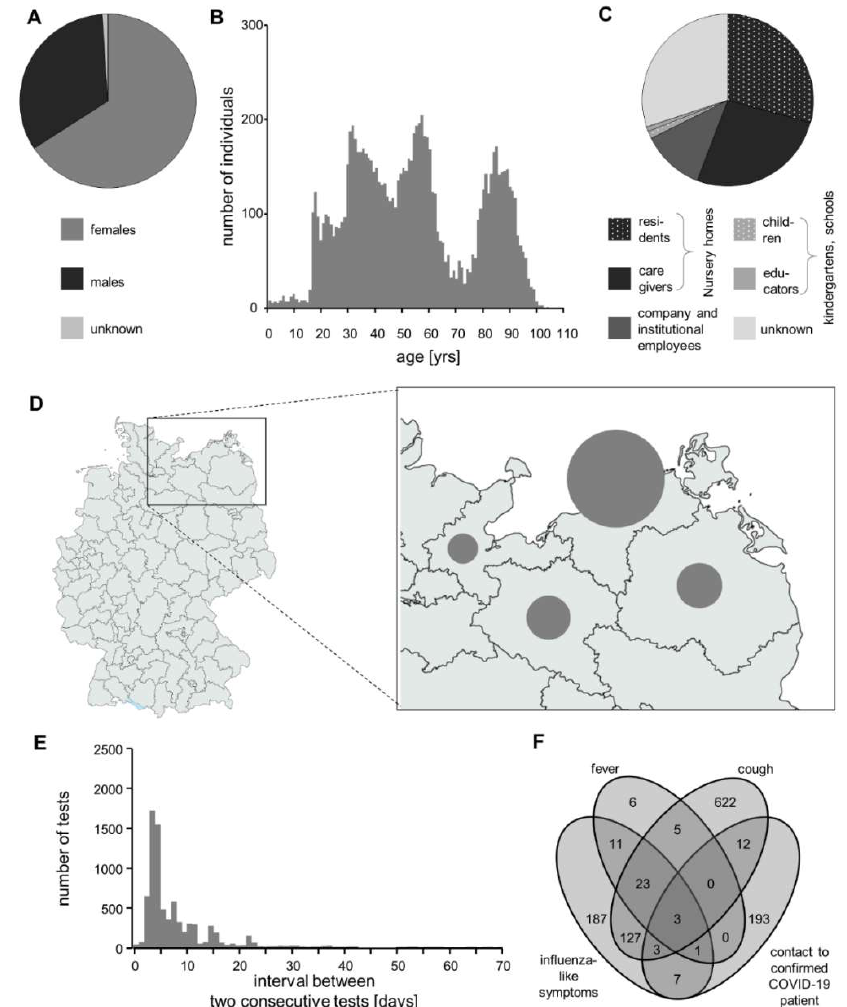
Figure 2. Cohort of tested individuals. ( A ) Stratification of individuals according to gender. ( B ) Distribution of ages at testing. ( C ) Stratification of individuals according to the background. ( D ) Geographical origin of the tested individuals. In the enlargement to the right, the relative size of the circles denotes the number of individuals from the corresponding area. ( E ) Distribution of intervals between tests upon recurrent testing. ( F ) Venn-diagram showing how often the indicated four items were associated with each other.